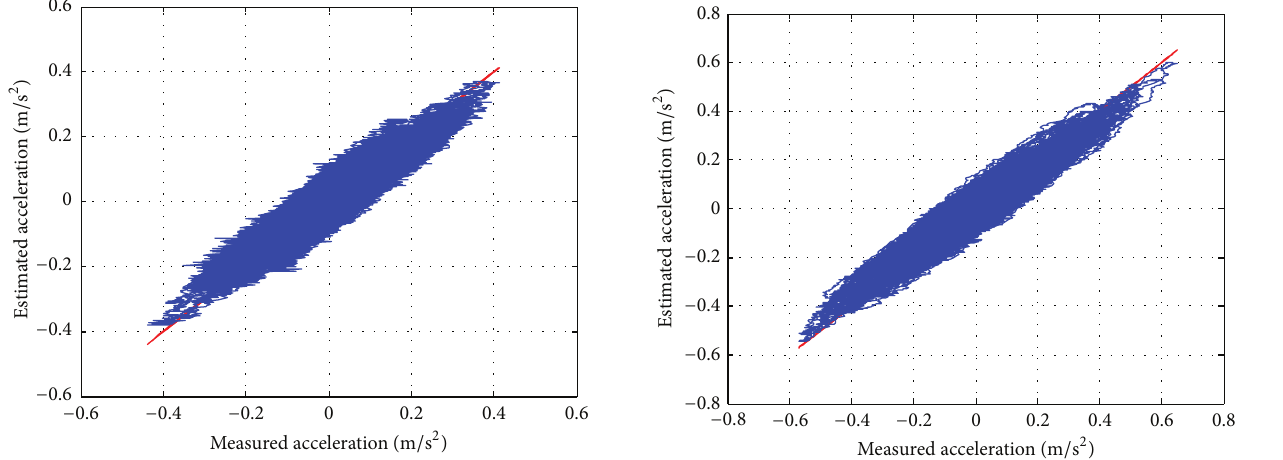
Figure 12: Correlogram between the measured and estimated acceleration for Case 2 (correlation coefficient = 0.948).